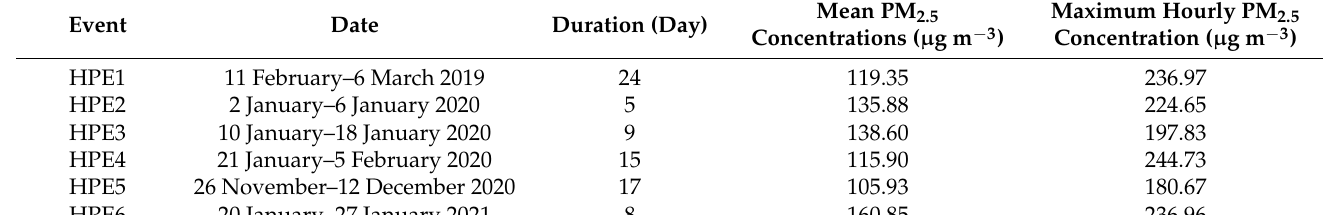
Table 3. Six heavy PM 2.5 pollution episodes (HPEs) in Henan pre- to post-COVID-19.